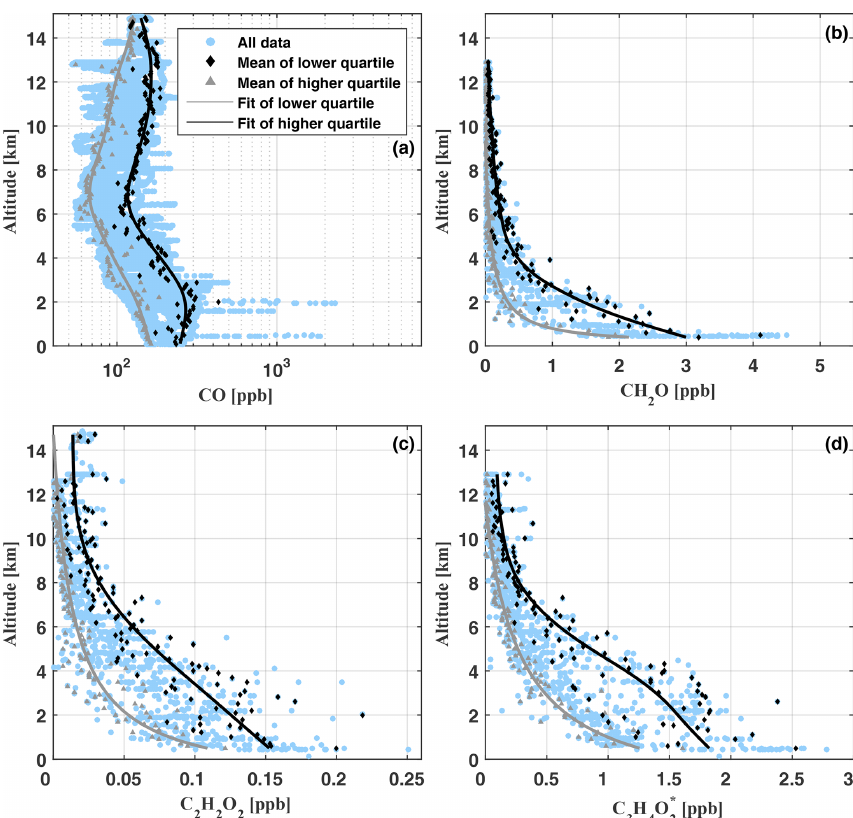
Figure 9. Vertical profiles of CO (a) , CH 2 O (b) , C 2 H 2 O 2 (c) , and C 3 H 4 O ∗ (d) as measured during flights AC09, AC11, AC12, and AC13 2 (blue circles). Note the logarithmic scale of the x axis in (a) . For AC09, there are no CO data available. The grey lines indicate a spline fit (a) and least-squares fits (b–d) through the lower quartile of the data (grey triangles) in 100m altitude bins. The black lines show corresponding fits through the mean of the upper quartile (black